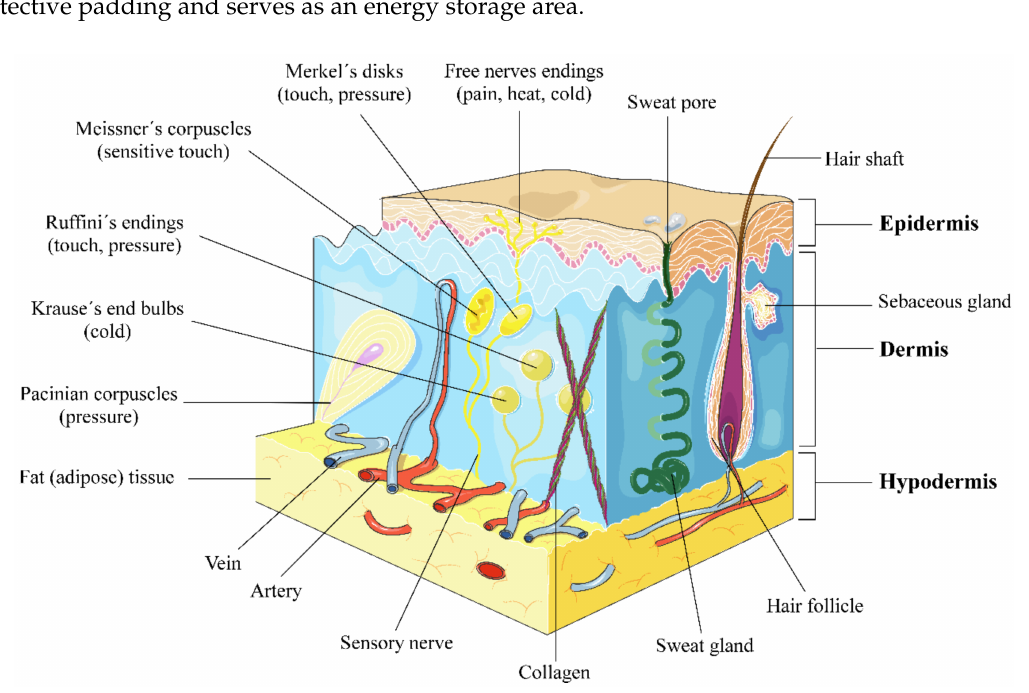
Figure 1. Human skin anatomy. There are three mechanoreceptor categories: tactile, proprioceptors and baroreceptors. The four major types of tactile mechanoreceptors are Merkel’s disks, Meissner’s corpuscles, Ruffini’s endings, and Pacinian corpuscles. The fifth type of mechanoreceptor, Krause’s end bulbs, is found only in specialised regions to detect cold. Free nerve endings are sensitive to painful stimuli, to hot and cold, and to light touch. This figure was created using Servier Medical Art [19], licensed under the Creative Commons Attribution 3.0 Unported License (www.creativecommons.org/